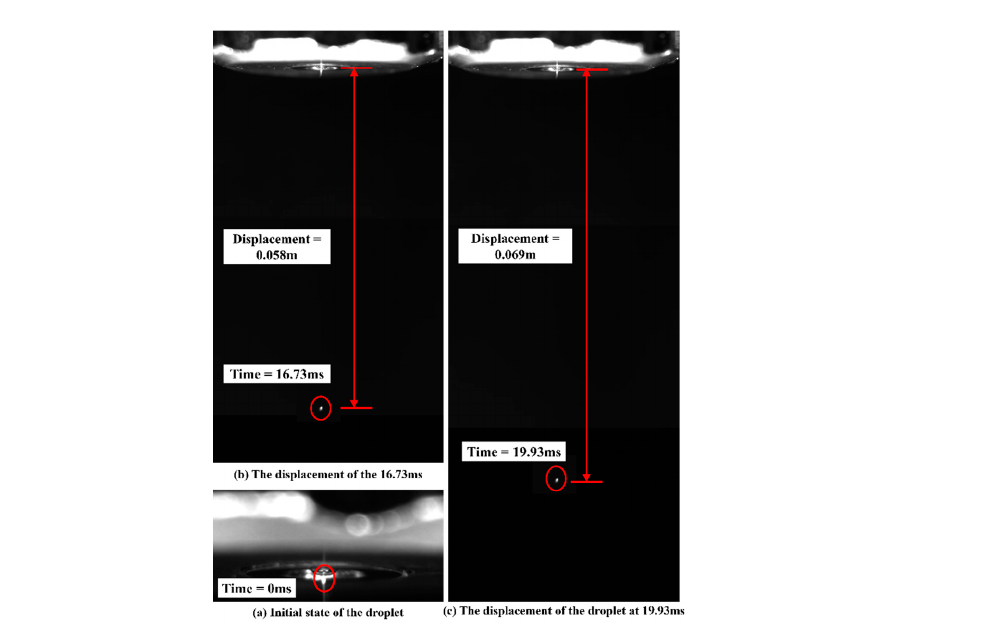
Figure 9. Different sizes of nozzle and needle samples.